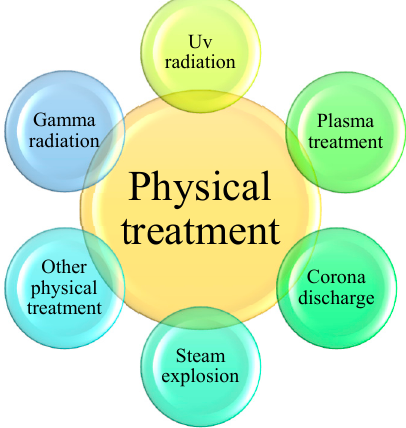
Figure 7. Different types of physical treatment for natural fibers.